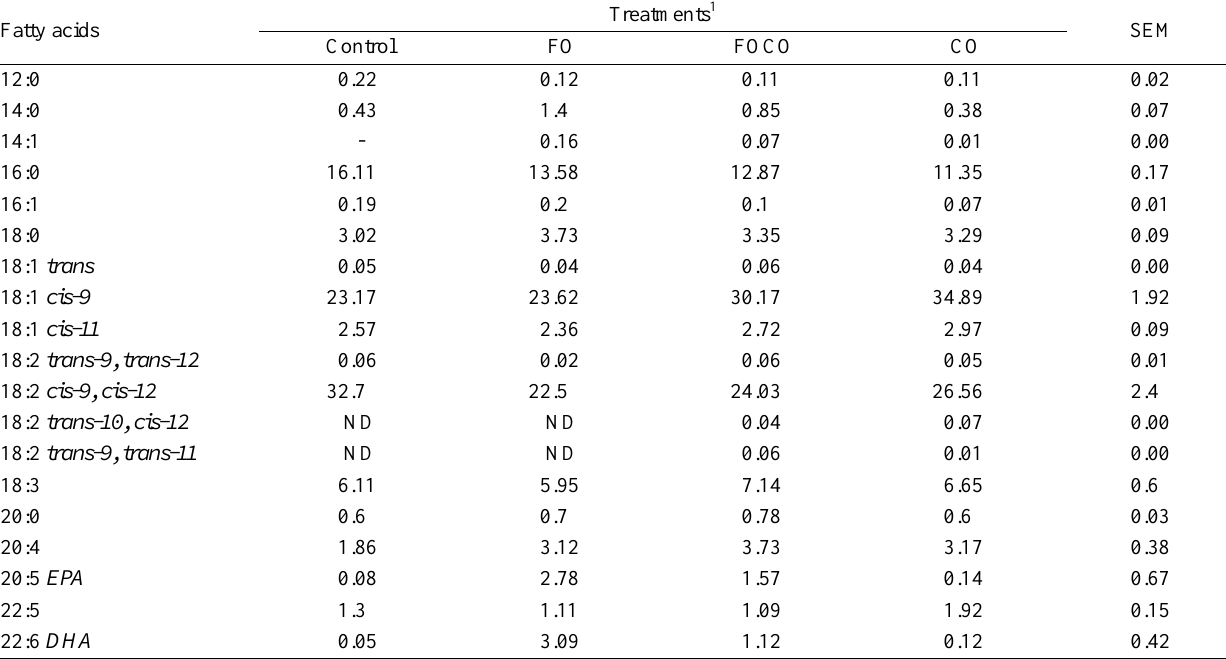
Table 2. Fatty acid composition (g/100 g of fatty acids) in dairy diets Fatty